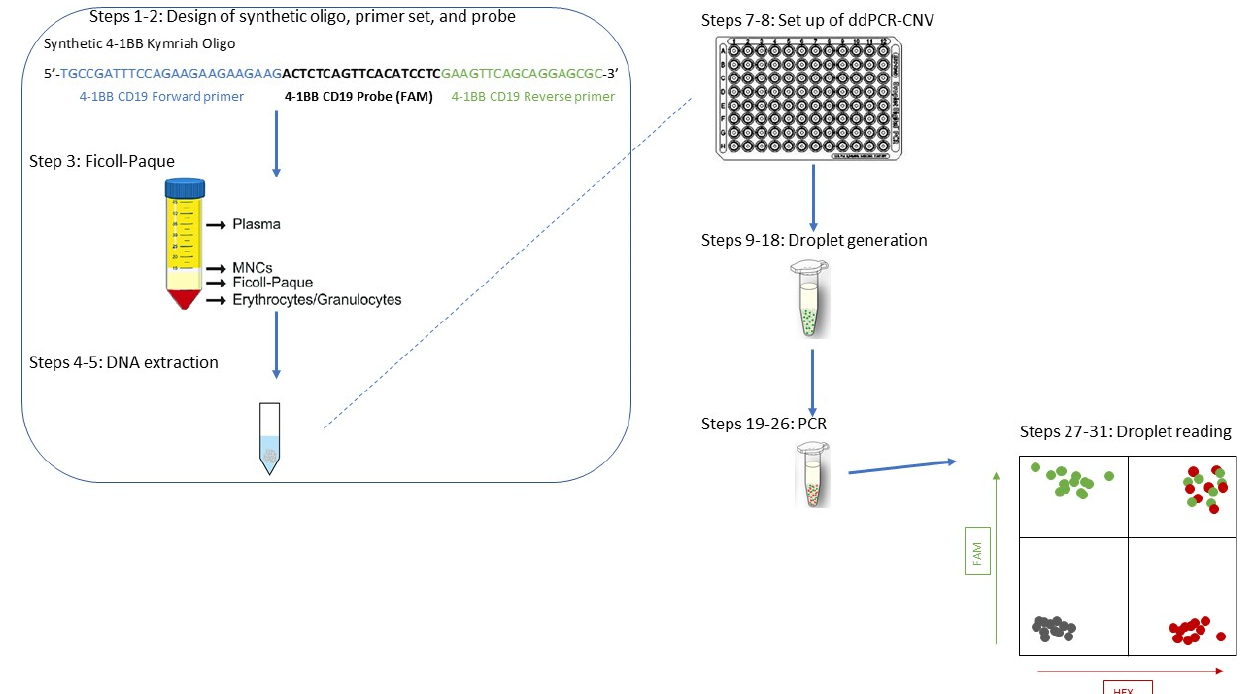
Figure 6. An illustration of a step-by-step procedure for the detection of tisagenlecleucel CAR T cells using the suggested ddPCR-CNV protocol. The design of the oligo and corresponding primers and probes is described in Steps 1–3, followed by the isolation of desired cell population from the patient’s sample taken in clinic (Step 4) and DNA extraction (Step 5). The following steps, 6–9, all relate to the ddPCR-CNV protocol.